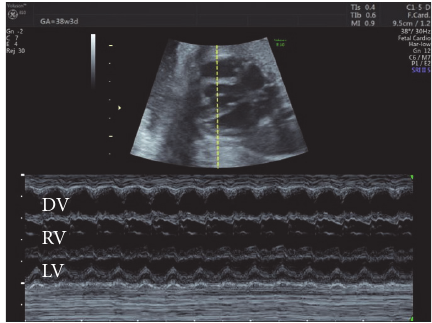
Figure 2: Fetal M-mode ultrasound: four-chamber view showing the diverticulum, right ventricle, and left ventricle. DV, diverticu- lum; LV, left ventricle; RV, right ventricle.